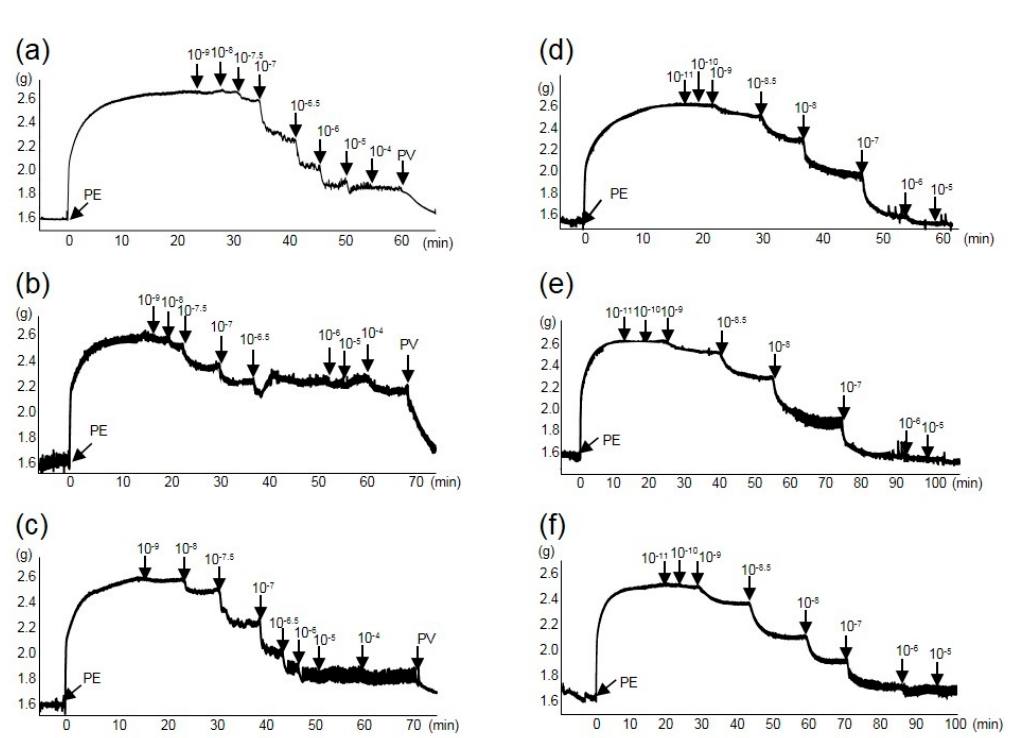
Figure 1. Representative acetylcholine (ACh) and sodium nitroprusside (SNP) relaxation profiles of thoracic aorta rings from the test animals. ( a ) ACh-Wistar Kyoto rat (WKY) group; ( b ) ACh-spontaneously hypertensive rat (SHR)-control group; ( c ) ACh-SHR- Eucommia leaf extract (ELE) group; ( d ) SNP-WKY group; ( e ) SNP-SHR-control group; and ( f ) SNP-SHR-ELE group. ACh and SNP were added cumulatively at concentrations of 10 − 9 –10 − 4 M and 10 − 11 –10 − 5 M, respectively, to 0.3 μ M phenylephrine (PE)-contracted thoracic aorta rings. PV, papaverine.